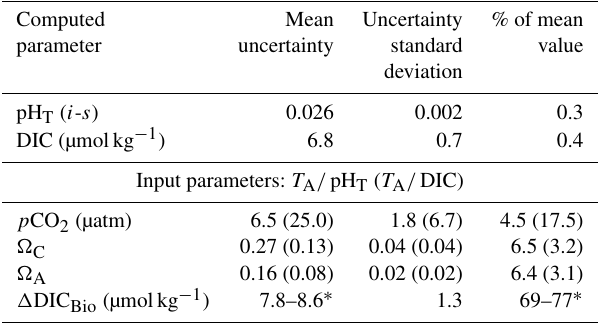
Table 2. Mean uncertainties of parameters computed in CO2SYS, their standard deviations and their relative weight with respect to the mean value of each parameter, for different carbonate parameter input